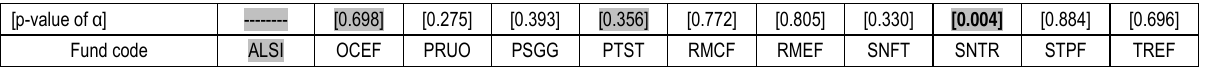
Table 2 (cont.). Fund performance (Sub-period 2: 7 May 2007 to 2 Sep